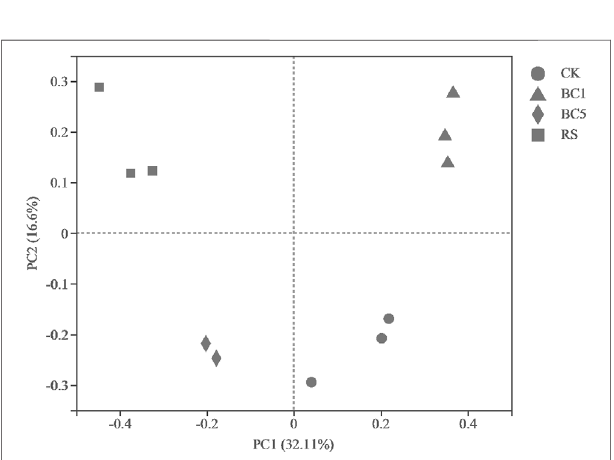
FIGURE 2 | Principal coordinate analysis (PCoA) based on Bray – Curtis distances of bacterial communities for different treatments. CK: